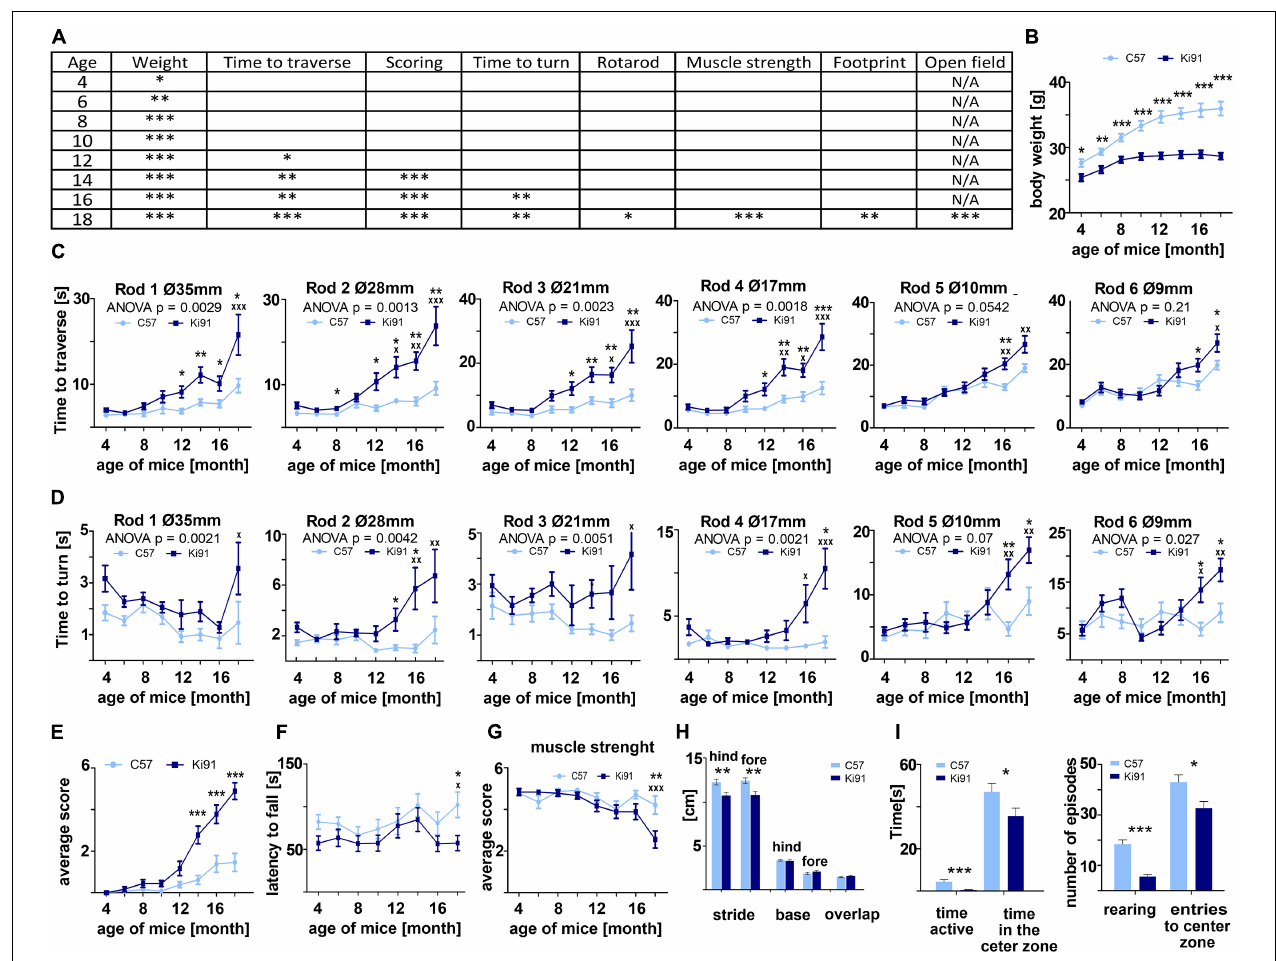
FIGURE 1 | Progressive motor deficits and other disease symptoms in Ki91 SCA3/MJD mice. Ki91 mice presented a gradual decline in several motor and non-motor functions measured by elevated beam walk, rotarod, monitoring of body weight, muscle weakness, and other tests. (A) Progressive reduction of body weight gain was observed starting from 4-month-old mice; on average, mut/mut animals at 12 months of age displayed 16.4% less body weight compared to WT animals ( p < 0.001; two-sample t -test) (B) . In the elevated beam walk test (C,D) “time to turn” and “traverse time” parameters were measured on six rods with decreasing diameter (diameter of rods are indicated by Ø in mm). A total of 12-month-old Ki91 mice needed significantly more time to traverse on rods 1–4, whereas older 16-month-old mice also needed more time on rods 5–6. (C) A total of 16-month-old animals needed more time to turn on all rods (D) . In the scoring test, 14-month-old Ki91 mice presented symptoms characteristic for SCA3: incoordination, gait disturbances, kyphosis, and hind limb clasping (E) . A total of 18-month-old mice showed motor incoordination in accelerated rotarod (4–40 rpm in 9.5 min) (F) , muscle weakness (G) , and differences in stride length in footprint test (H) . A total of 18-month-old mice also presented a cognitive deterioration marked by a decreased amount of time spent in the center zone in the Open field test and a decreased number of rearing (I) . Two-way ANOVA with Bonferroni post hoc test ( p ≤ 0.05; total number of biological replicates: n = 36, n = 18 per genotype), error bars: SEM. Asterisks denotes a two-way ANOVA calculated separately for each test consisted of 4 days at each age (* p < 0.05, ** p < 0.01, *** p < 0.001); x-symbol represent two-way ANOVA calculated after completion of testing all ages ( x p < 0.05, xx p < 0.01, xxx p <